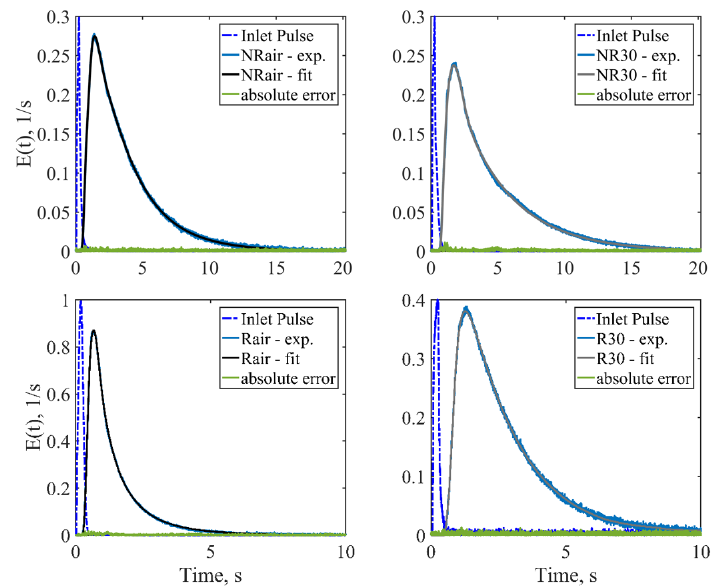
Figure 5. Experimental RTD and superimposed CRN fit for each operating condition, Table 1.